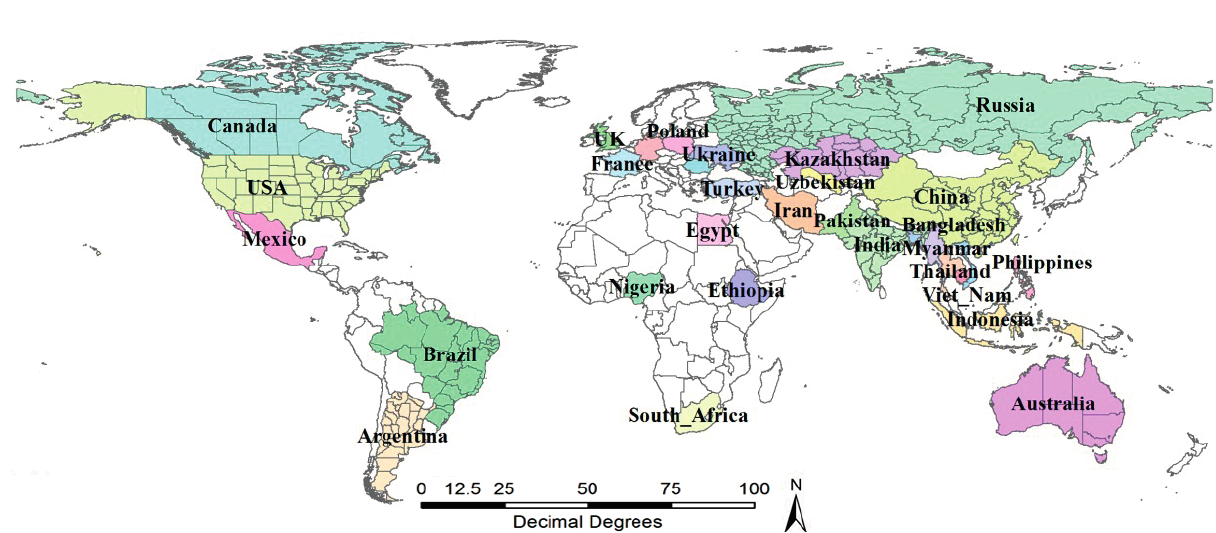
Figure 5. Thirty-one key countries in the CropWatch system.